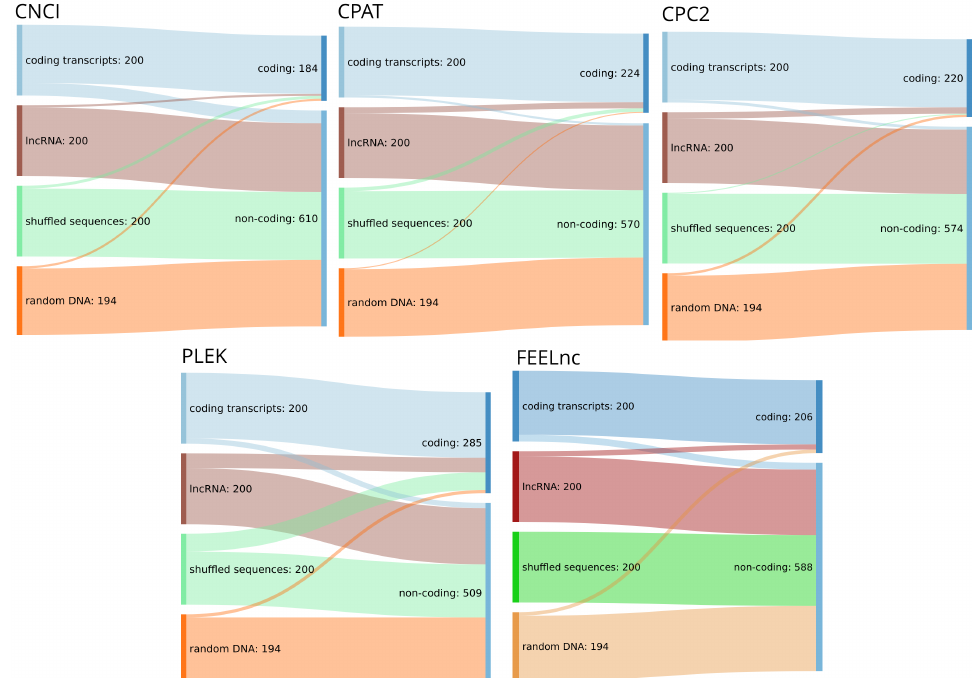
Figure 2. Sankey diagrams for the input dataset consisting of 200 randomly chosen lncRNA, 200 cod- ing transcripts, dinucleotide shuffled versions of the latter and 194 randomly chosen sequences from the human genome (hg38) and corresponding annotation (RefSeq database [40] v38) and their assignment to coding or non-coding classes by five high-impact classification tools. All tools were run with standard settings where